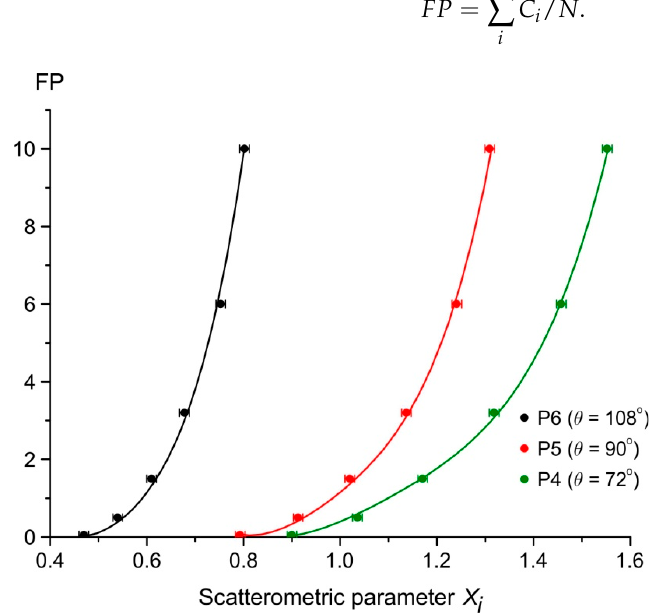
Table 1. Coefficients of 𝐴 (cid:3036)(cid:3037) .